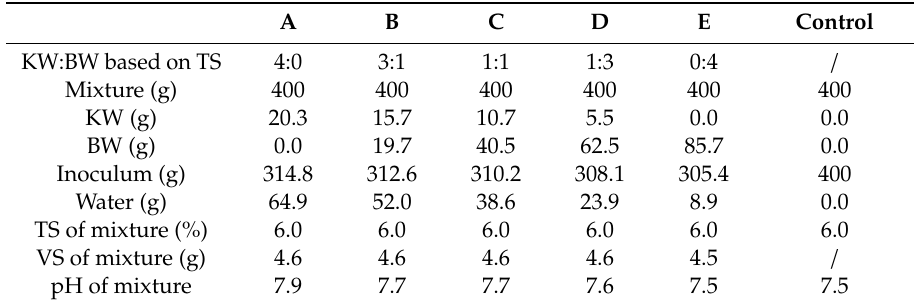
Table 2. Di ff erent prepared substrates for the biochemical methane potential (BMP)